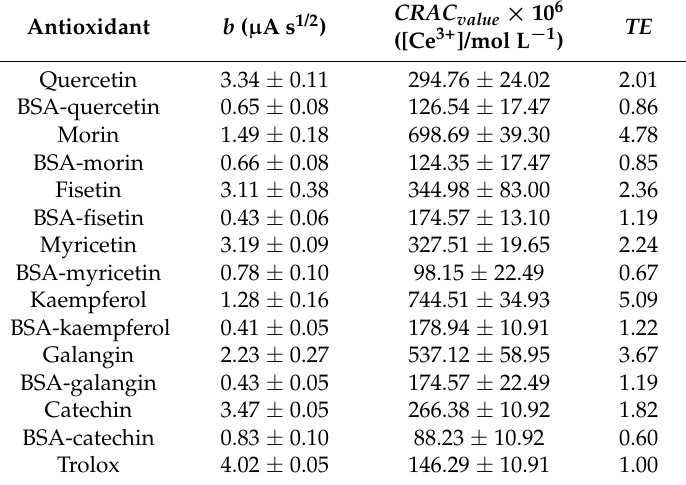
Table 1. Cottrell slopes, ceric reducing/antioxidant capacity (CRAC) values and Trolox equivalent (TE) values for the addition of 25 µ mol L − 1 of antioxidant before and after complexing with BSA.